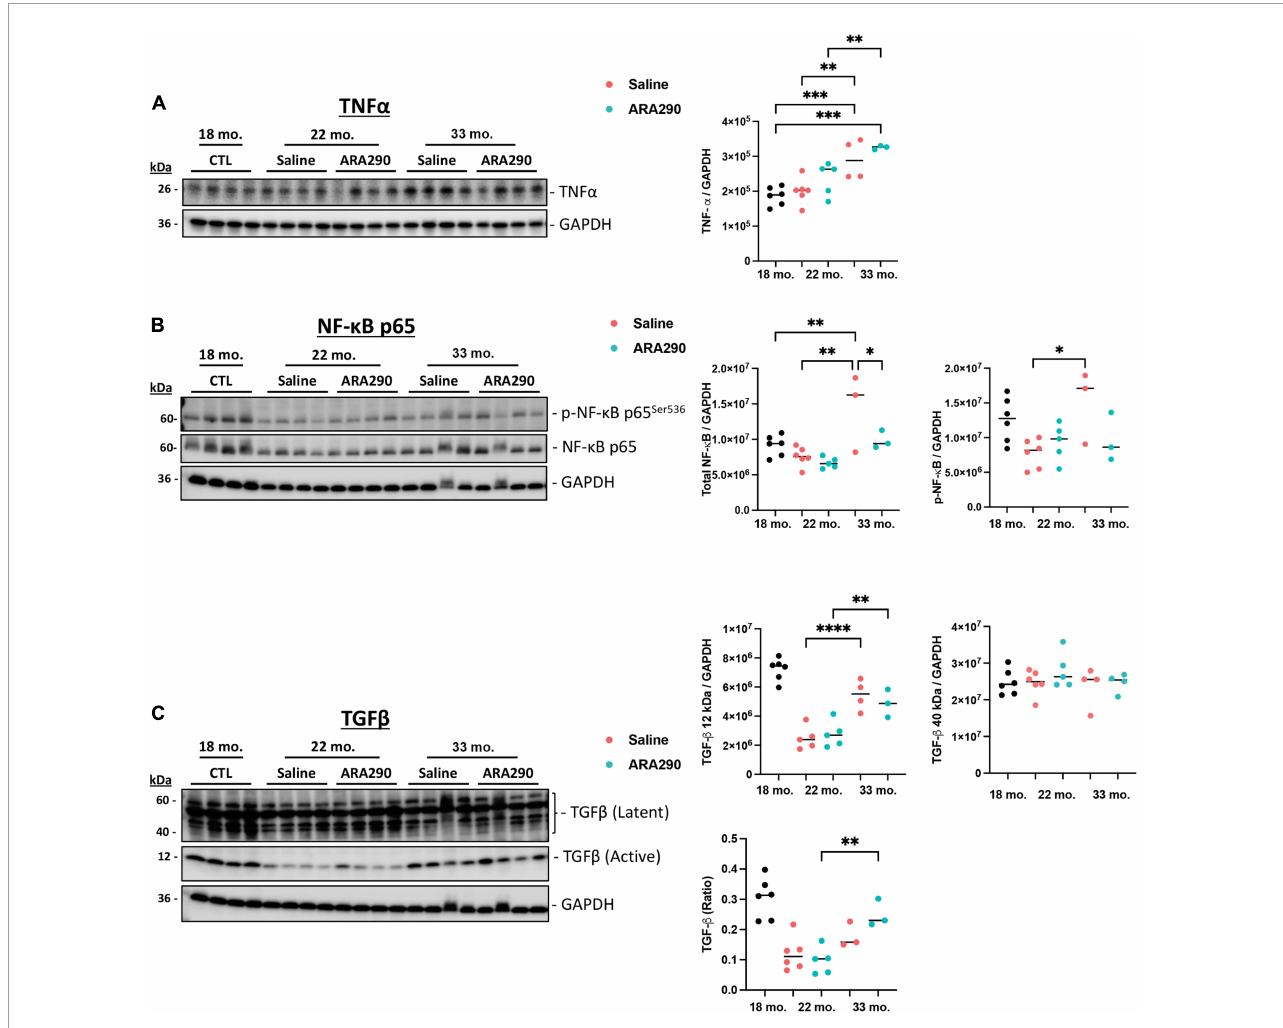
FIGURE6 Western blot analysis depicting expression levels of TNF- α (A) , p-NF- κ B and total NF- κ B (B) , and TGF- β (12 and 40 kDa) (C) relative to GAPDH at 18 ( n = 6), 22 (Saline n = 6; ARA290 n = 5), and 33 (Saline n = 4; ARA290 n = 4) months of age. Statistically significant interactions between treatment groups are shown ( ∗ P < 0.05, ∗∗ P < 0.01, ∗∗∗ P < 0.001, ∗∗∗∗ P < 0.0001).